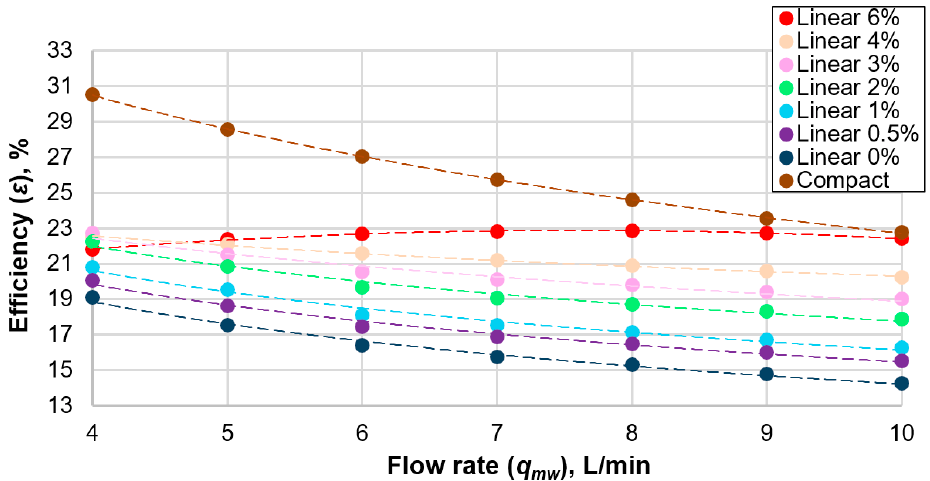
Figure 8. Efficiency of the shower heat exchangers determined for T cw = 16 °C.